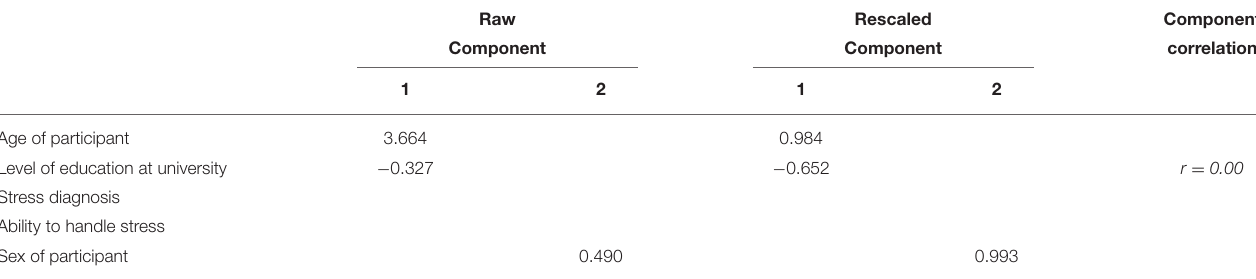
TABLE 5 | Rotated component matrix a and component covariance correlation after varimax